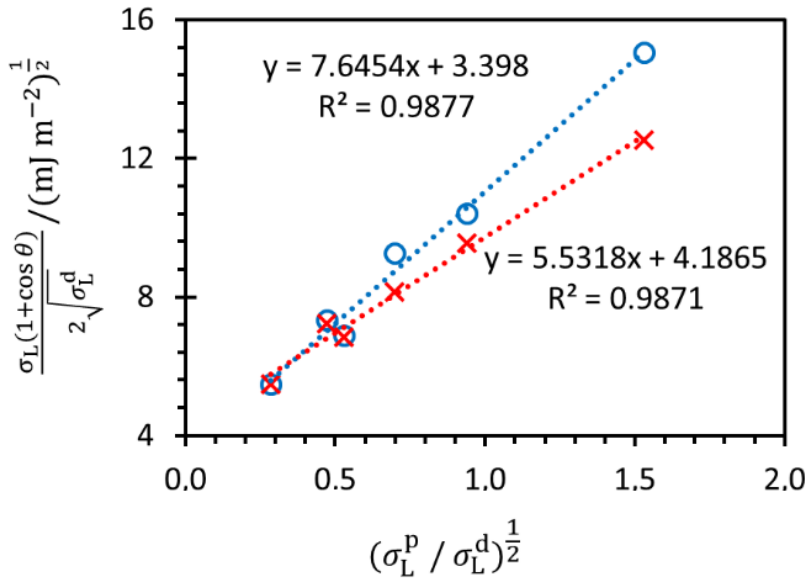
Figure 3. Results for silica ( O ) and titanium ( X ) contact angle measurements with six different test fluids interpreted by Owens–Wendt model (Equation (1)).